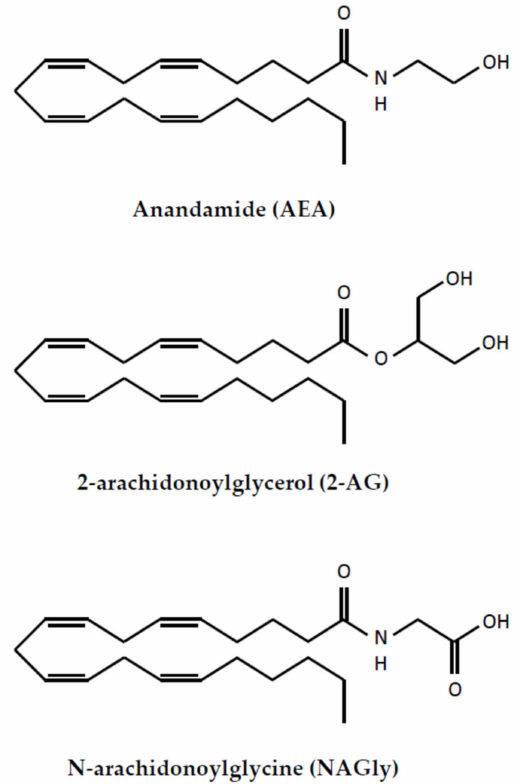
Figure 1. The structure of